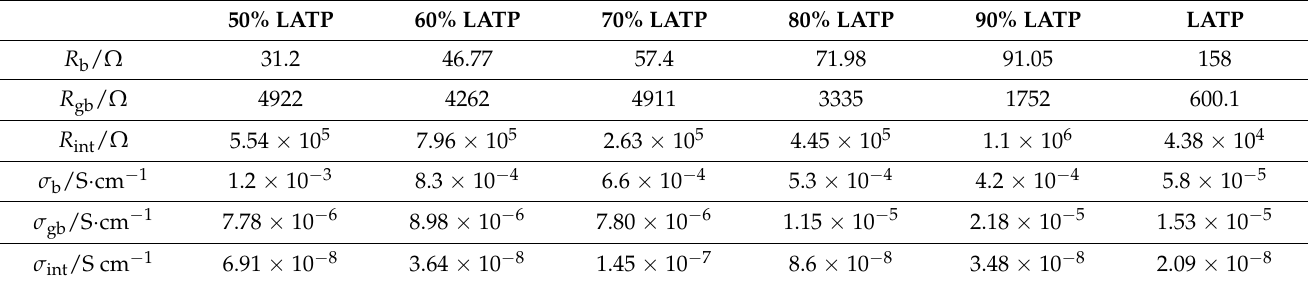
Table 1. Bulk impedance, grain boundary resistance, and ionic conductivities of composite solid electrolytes with different content of